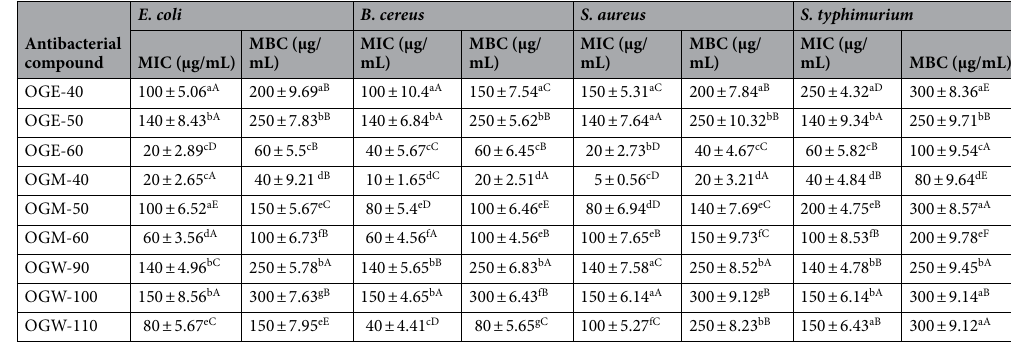
Table 7. Minimum inhibitory and bactericidal concentration (MIC, MBC) against E. coli , B. cereus , S. aureus , and S. typhimurium for O. gratissimum extracts. Values shown are means of three replicates (n = 3). Values with different superscript lowercase letter (a–g) for MIC and MBC data within each column are significantly different ( P ≤ 0.05). Values with different superscript uppercase letter (A–E) within each row are significantly different ( P ≤ 0.05).